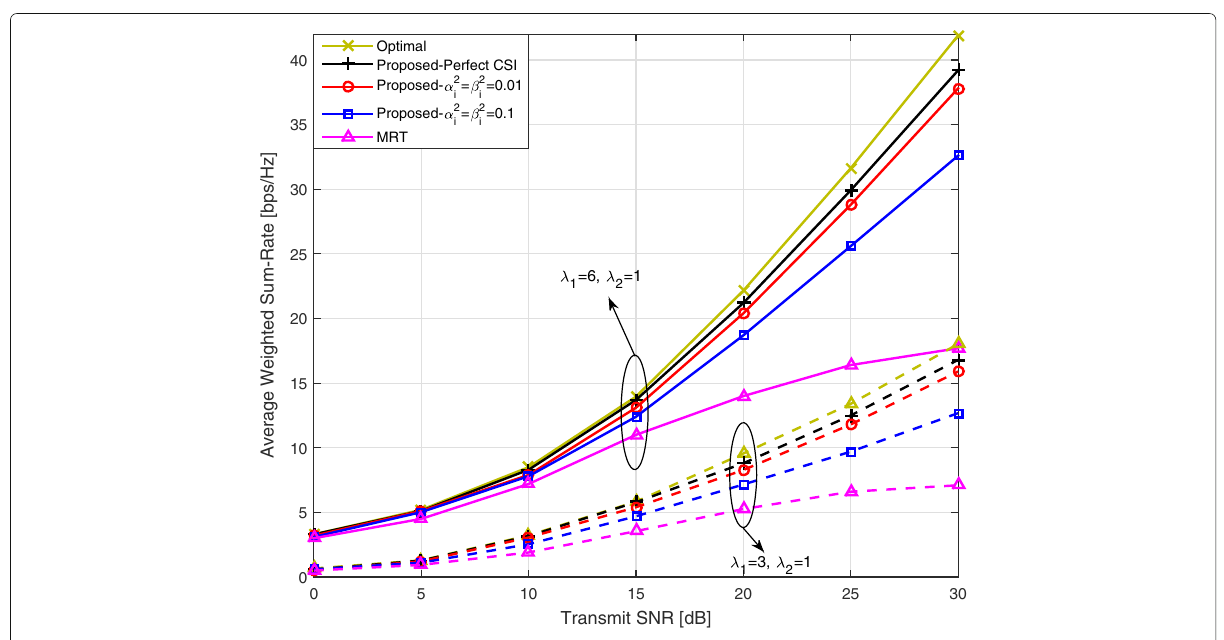
Fig. 2 The average weighted SR versus the transmit SNR